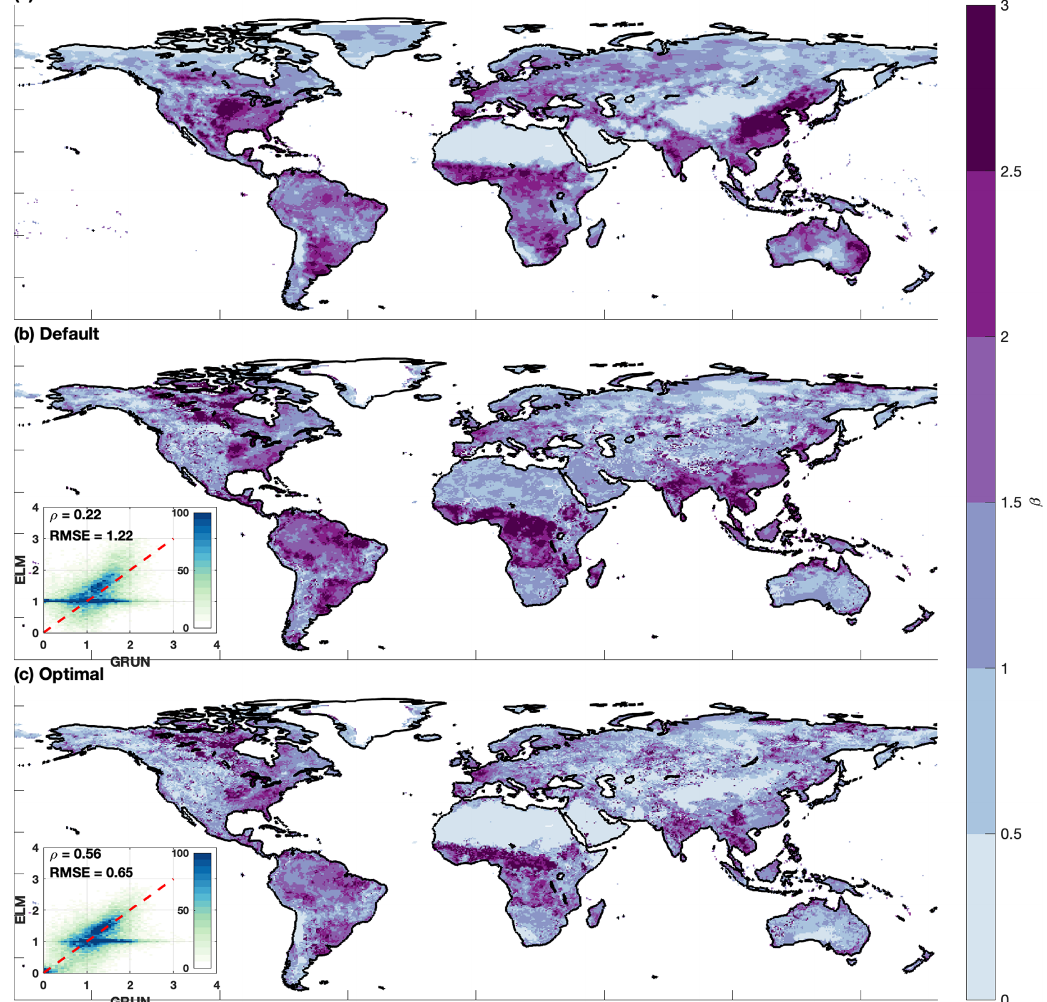
Figure 9. Sensitivity of runoff to precipitation ( β ) estimated from the (a) GRUN runoff dataset, (b) ELM simulation with default parameter, and (c) ELM simulation with optimal parameter. The inserts show the scatterplots with density for cell-to-cell comparison of β between GRUN and ELM